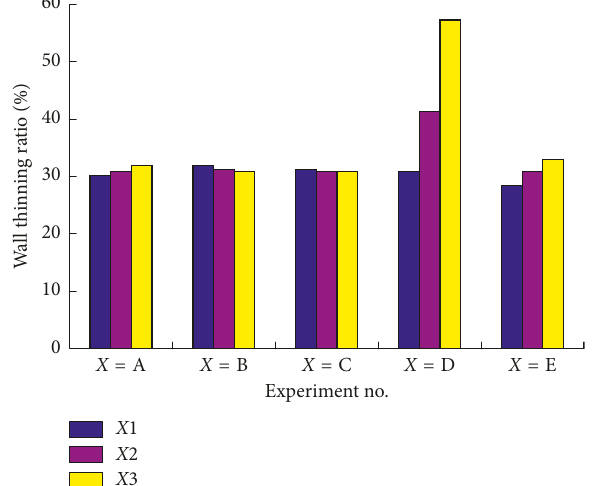
Figure 11: Relationship between the experimental thickness thinning ratio and the process parameters.